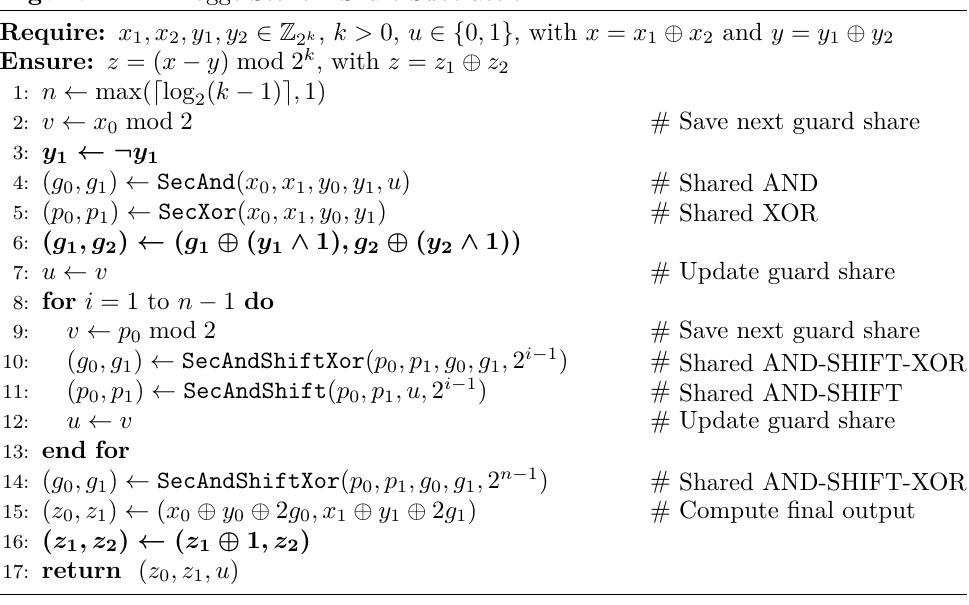
Algorithm 14 Kogge-Stone 2-Share Subtraction